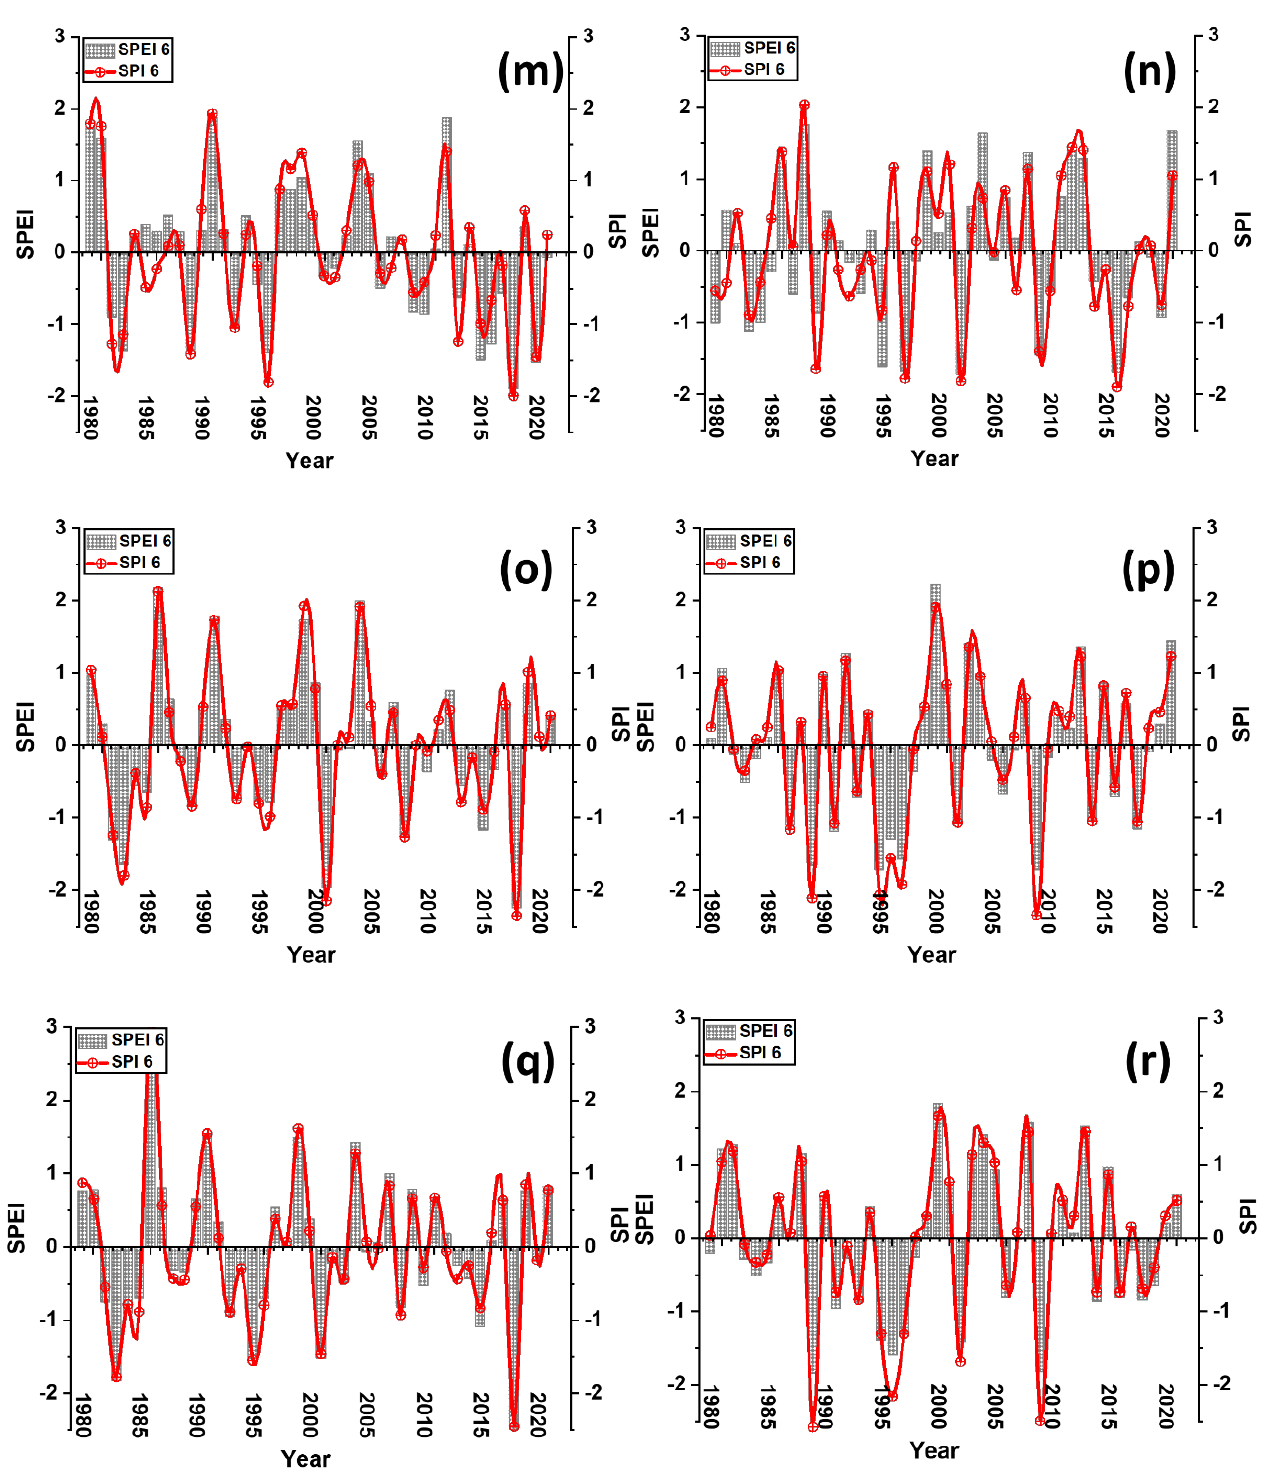
Figure 6. SPEI and SPI 6 ( a , b ) Gangwon, ( c , d ) Gyeonggi, ( e , f ) Jeju, ( g , h ) North Chungcheong, ( i , j ) North Gyeongsang, ( k , l ) North Jeolla, ( m , n ) South Chungcheong, ( o , p ) South Gyeongsang, and ( q , r ) South Jeolla for the month of June (left) and December